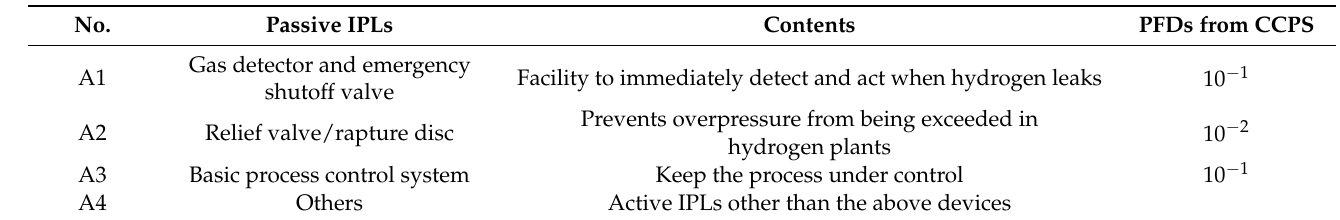
Table 5. PFDs (per year) for active